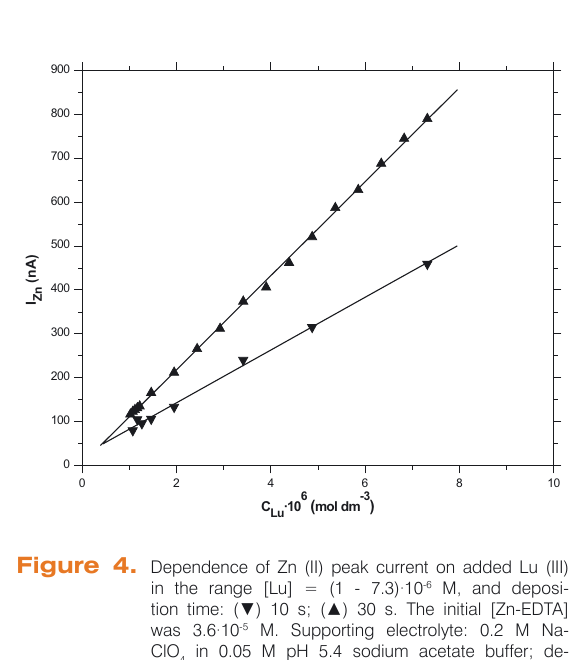
Figure 4. Dependence of Zn (II) peak current on added Lu (III) in the range [Lu] = (1 - 7.3)·10 -6 M, and deposi- tion time: ( ▼ ) 10 s; ( ▼ ) 30 s. The initial [Zn-EDTA] was 3.6·10 -5 M. Supporting electrolyte: 0.2 M Na- ClO in 0.05 M pH 5.4 sodium acetate buffer; de- 4 position potential: -1.200 V; sweep rate: 10 mV s -1 .